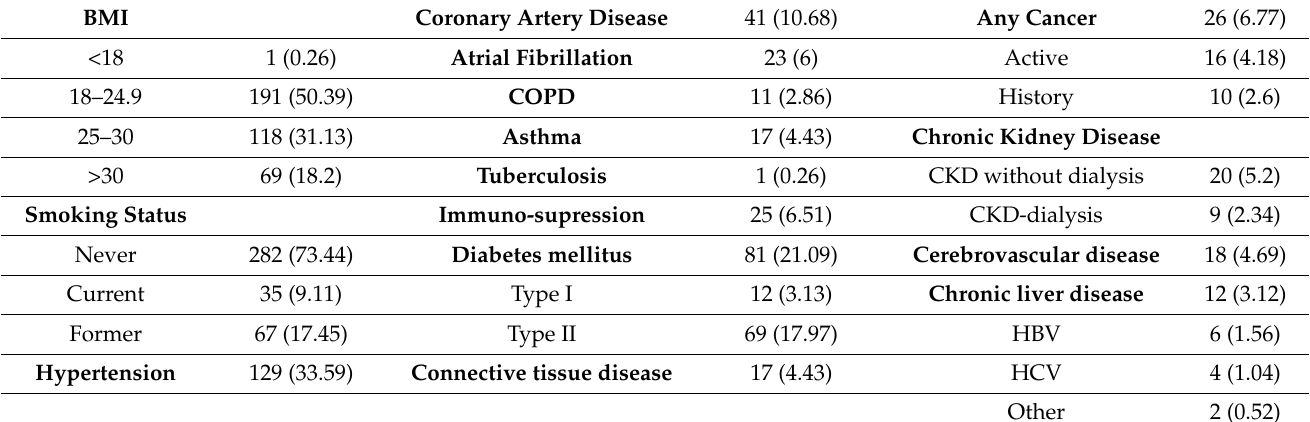
Table 1. Clinical and epidemiological characteristics of patients on admission.